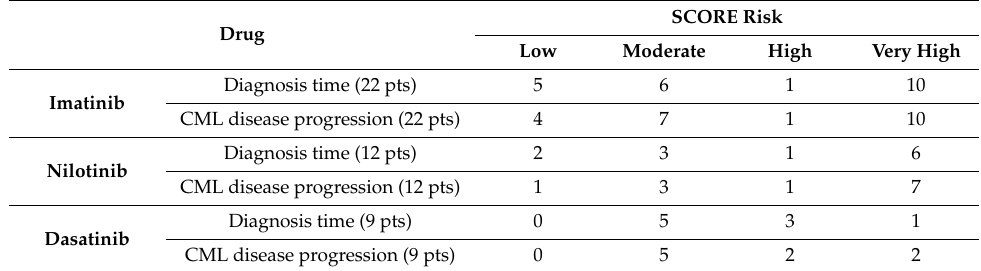
Table 4. Systematic Coronary Risk Evaluation (SCORE) risk in chronic myeloid leukaemia (CML) patients.